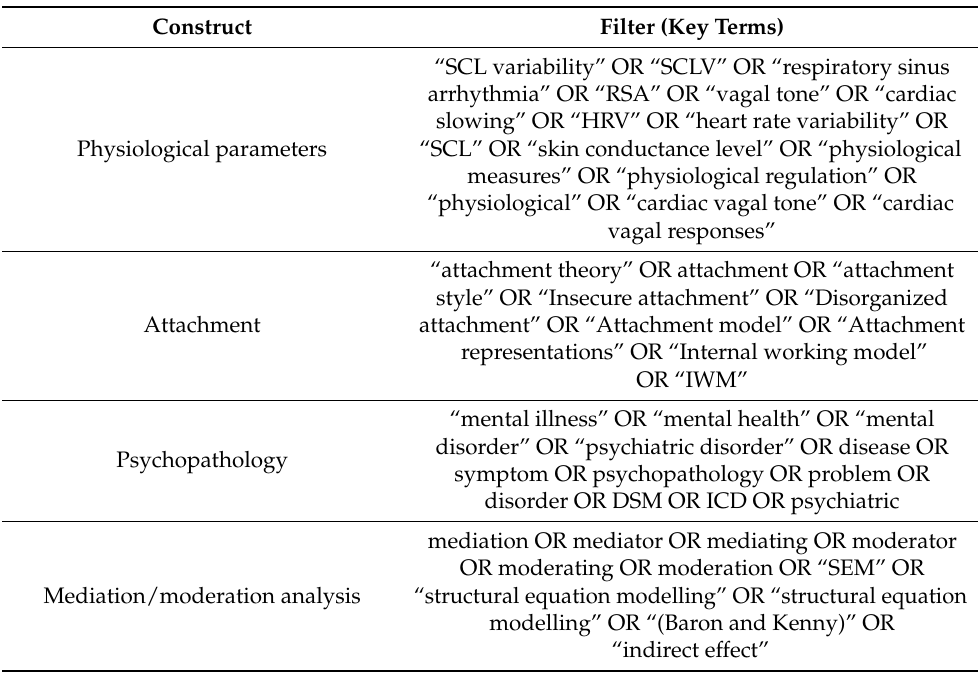
Table 1. Search key